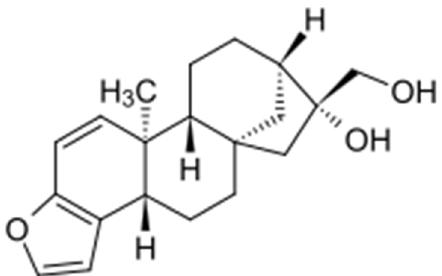
Figure 1. The structure of